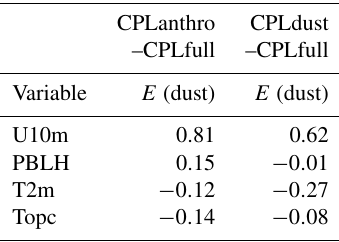
Table 2. Monthly averaged correlations between changes in dust emissions and changes in 10m wind speed (U10m), planetary boundary layer height (PBLH), 2m temperature (T2m) and total precipitation